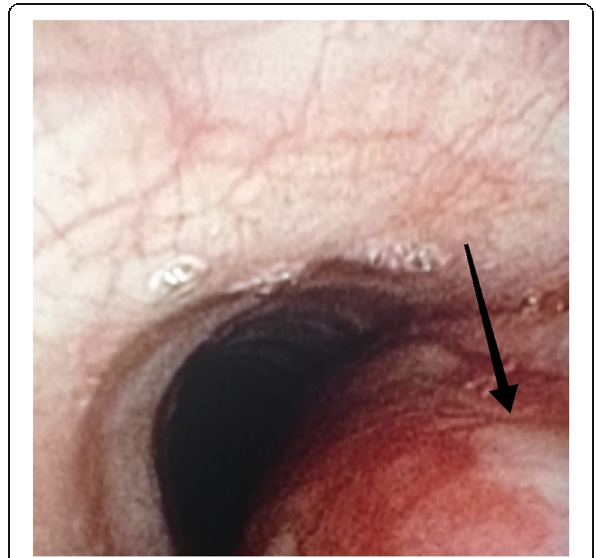
Fig. 2 Iatrogenic submucous tracheal rupture, 6 cm below the vocal cords, in the pars membranacea covered with fibrinous tissue that required no further